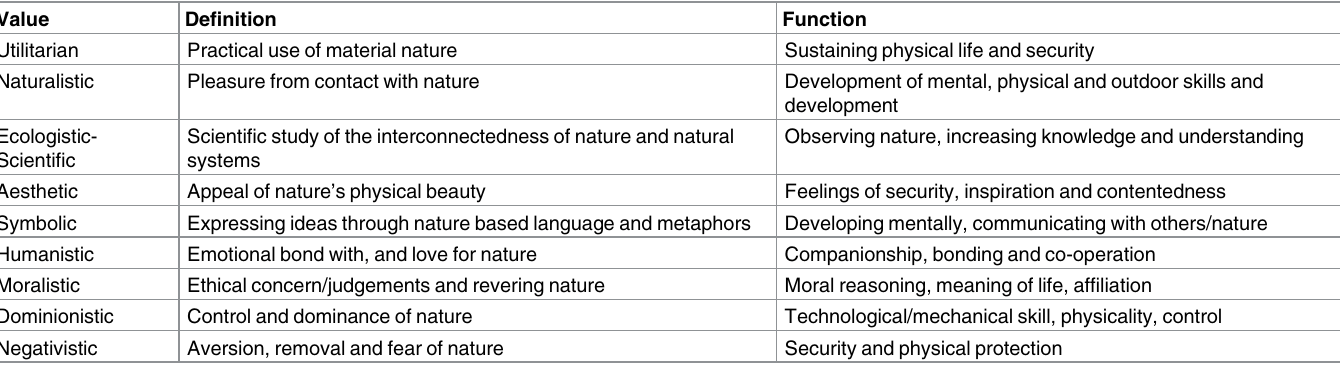
Table 1. The nine values of biophilia